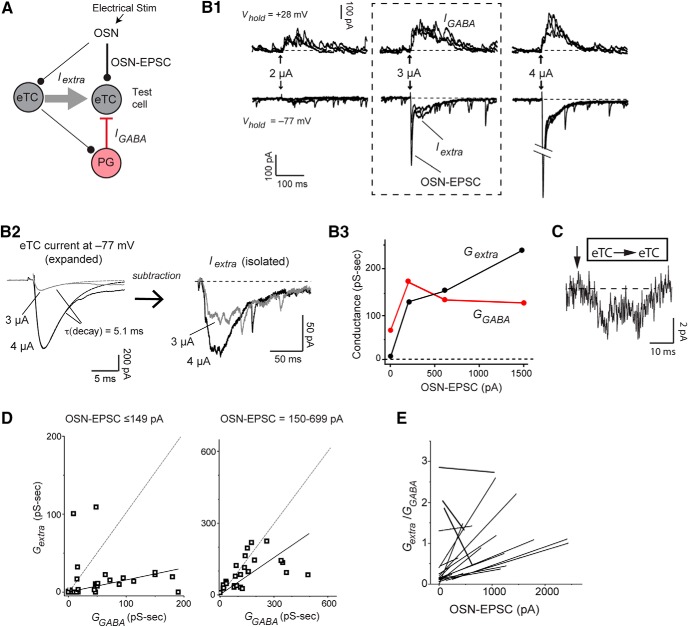
Extrasynaptic excitation and synaptic inhibition in eTCs following OSN stimulation. A, Simplified circuit reflecting currents measured in a voltage-clamped eTC following stimulation of OSNs. Components include the monosynaptic OSN-EPSC, Iextra due to activation of other eTCs (OSN-to-eTC-to-eTC), and a polysynaptic inhibitory current (IGABA) due mainly to feedback inhibition from PG cells (OSN-to-eTC-to-PG cell-to-eTC). Not shown is a potential feedforward pathway of inhibition mediated by ∼30% of PG cells directly excited by OSNs (Shao et al., 2009). B, Example eTC current responses. B1, Overlaid trials (three each) of excitatory currents (at Vhold = –77 mV) and inhibitory currents (at Vhold = +28 mV) evoked by OSN stimulation at three intensities (2, 3, and 4 µA). The 3-µA data in boxed region best illustrate the current components defined in A. Note that at the lowest intensity (2 µA), inhibition was much larger than excitation and the OSN-EPSC was barely detectable. B2, Iextra (right) was isolated by fitting the rise and most of the decay of the OSN-EPSC in the composite current (left) with a sum of two exponentials, then subtracting the derived estimate of the OSN-EPSC. Average currents (five trials) at two stimulus intensities are illustrated. B3, Integrated extrasynaptic (Gextra) and GABAergic (GGABA) conductances as a function of OSN-EPSC amplitude for this experiment. Each point reflects mean of five trials. C, Example excitatory current in an eTC evoked by single spikes in another eTC (at arrow) in an eTC-eTC pair recording (average of 12 trials). D, Summary of Gextra and GGABA measurements across 21 eTC recordings, sorted by amplitude of the cooccurring OSN-EPSC. Solid lines reflect linear regression fits of data points (one per recording), constrained to pass through the origin, added here for illustrative purposes. Dashed lines reflect unity. E, Linear regression fits of OSN-EPSC amplitude versus Gextra/GGABA ratio measurements from 19 individual eTC recordings. Each eTC recording had at least three OSN stimulation intensities sampled (actual data points not shown). Note positive slopes in all but three experiments, indicating that the conductance ratios generally rose with increasing OSN input.